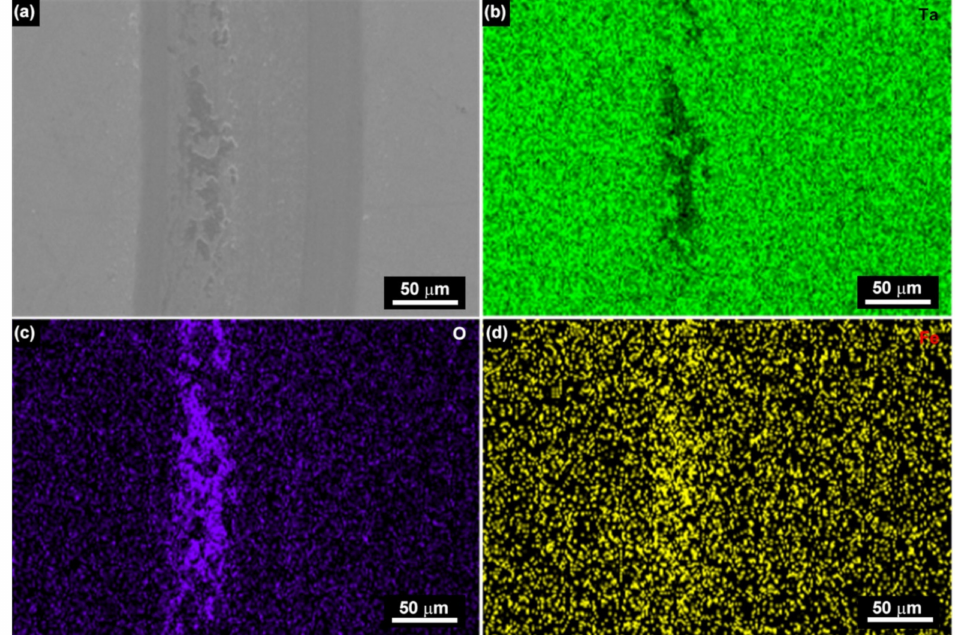
Figure 9. Typical SEM image ( a ) and corresponding EDX mapping ( b – d ) of the wear track of the coating deposited at − 100 V. ( b ), ( c ) and ( d ) are ascribed to Ta, O and Fe,